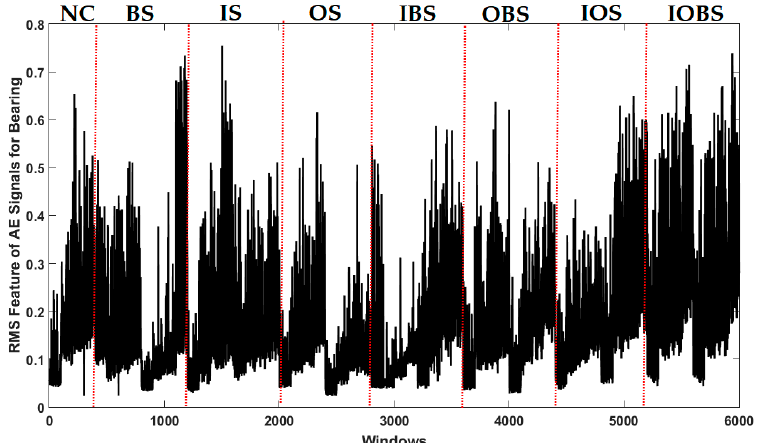
Figure 6. RMS of original AE signals for the bearing.